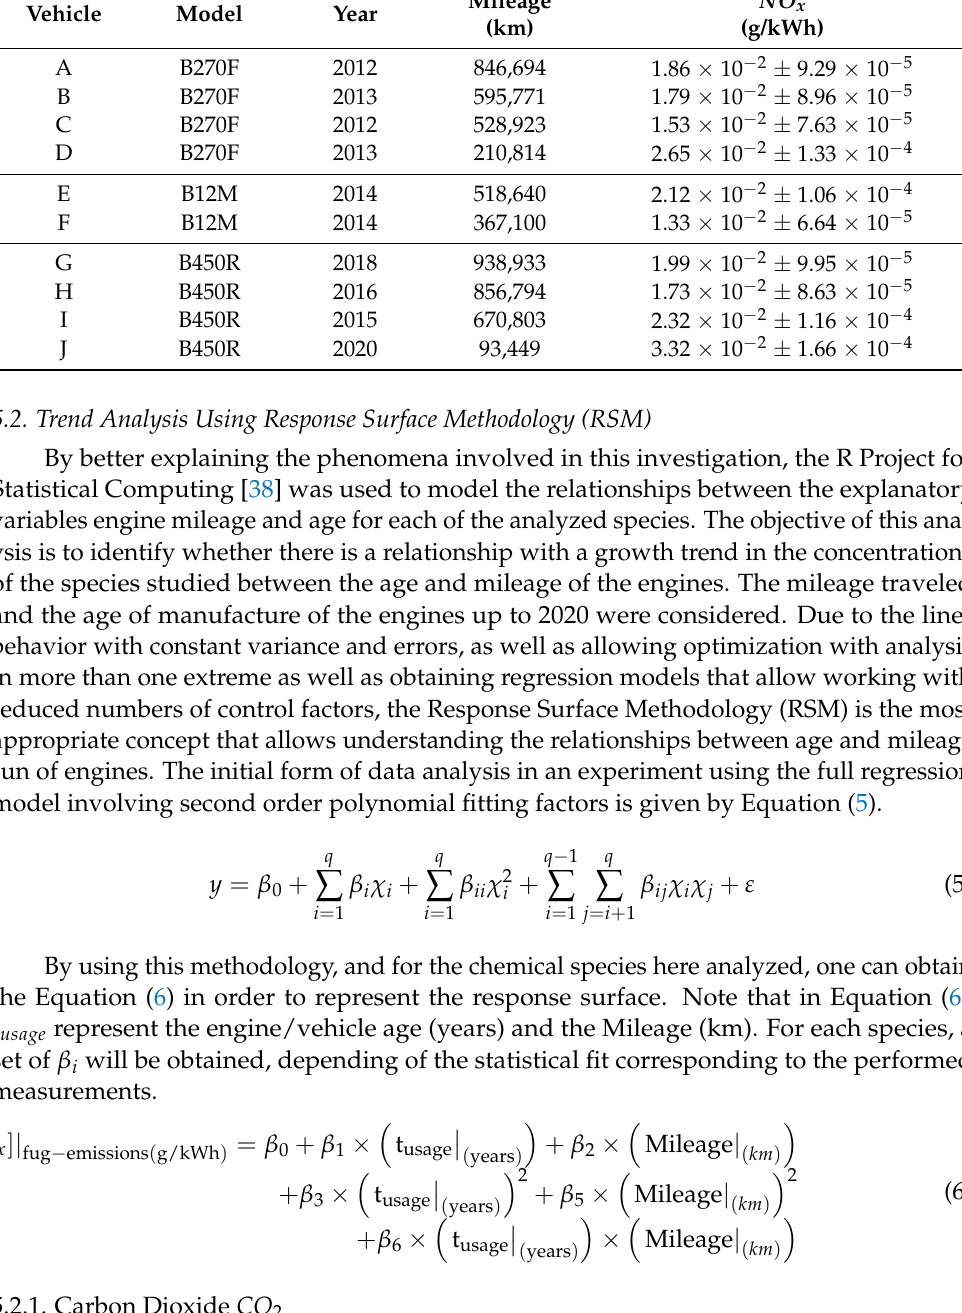
Table 8. Evolution of the Emissions of Oxides of NO x as a function of mileage traveled. Vehicle